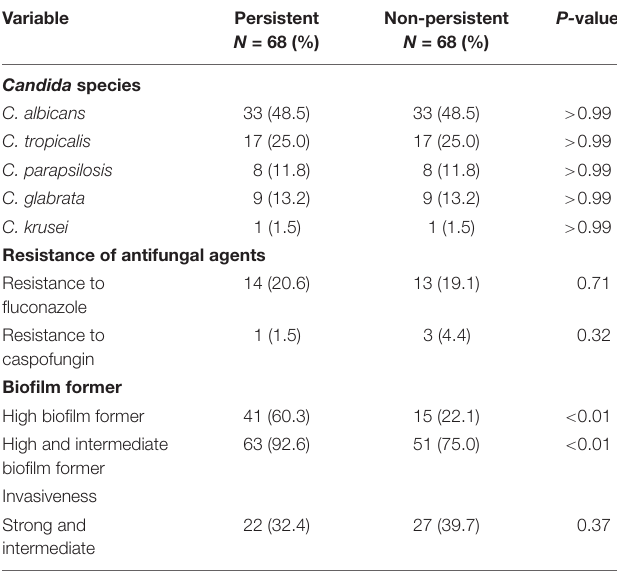
TABLE 3 | The microbiological characteristics of Candida strains isolated from the 136 adult patients with persistent and non-persistent candidemia after propensity-score matching.